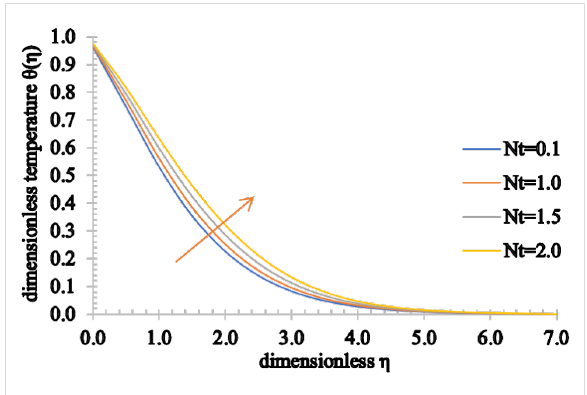
Figure 18: The temperature profile for increasing values of Nt .